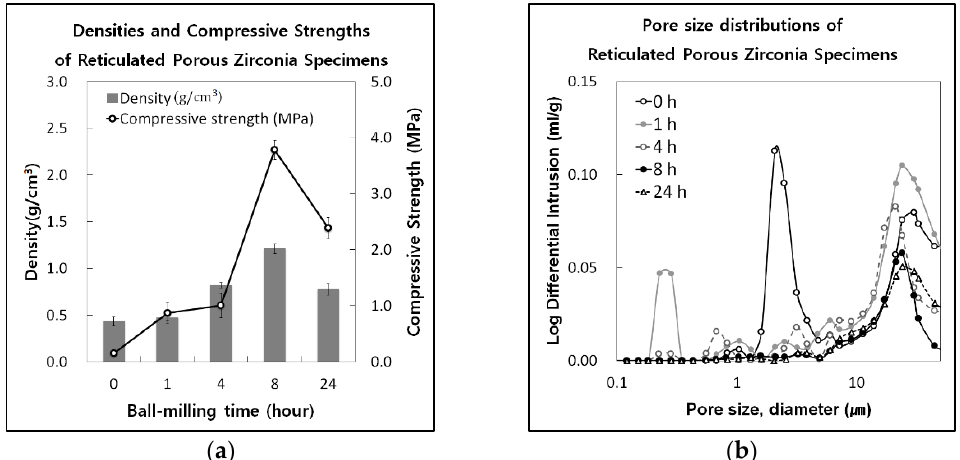
Figure 5. ( a ) Densities and compressive strength outcomes and ( b ) pore size distributions of reticu- lated porous zirconia specimen ball-milled for 0, 1, 4, 8, and 24 h.